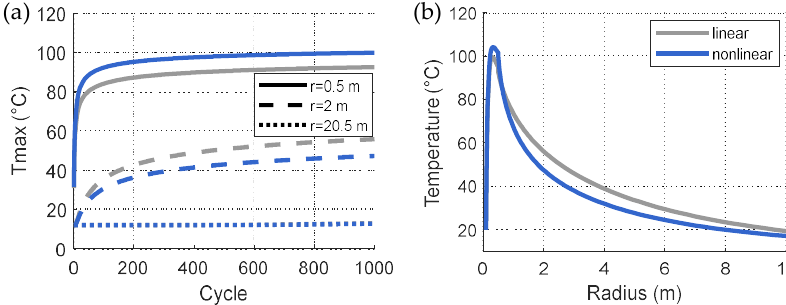
Figure 18. Comparison of temperature in the soil between the linear and nonlinear thermal models for the isolated pile cases: ( a ) maximum temperature at different locations and ( b ) temperature distribution along the radial direction at the end of 1000 cycle.